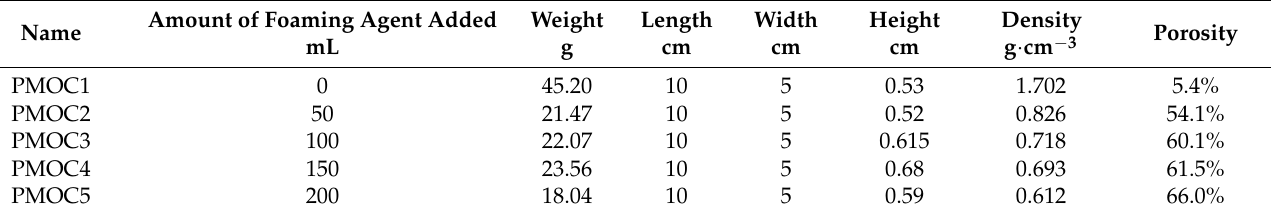
Table 1. Parameters of PMOC for different porosities.